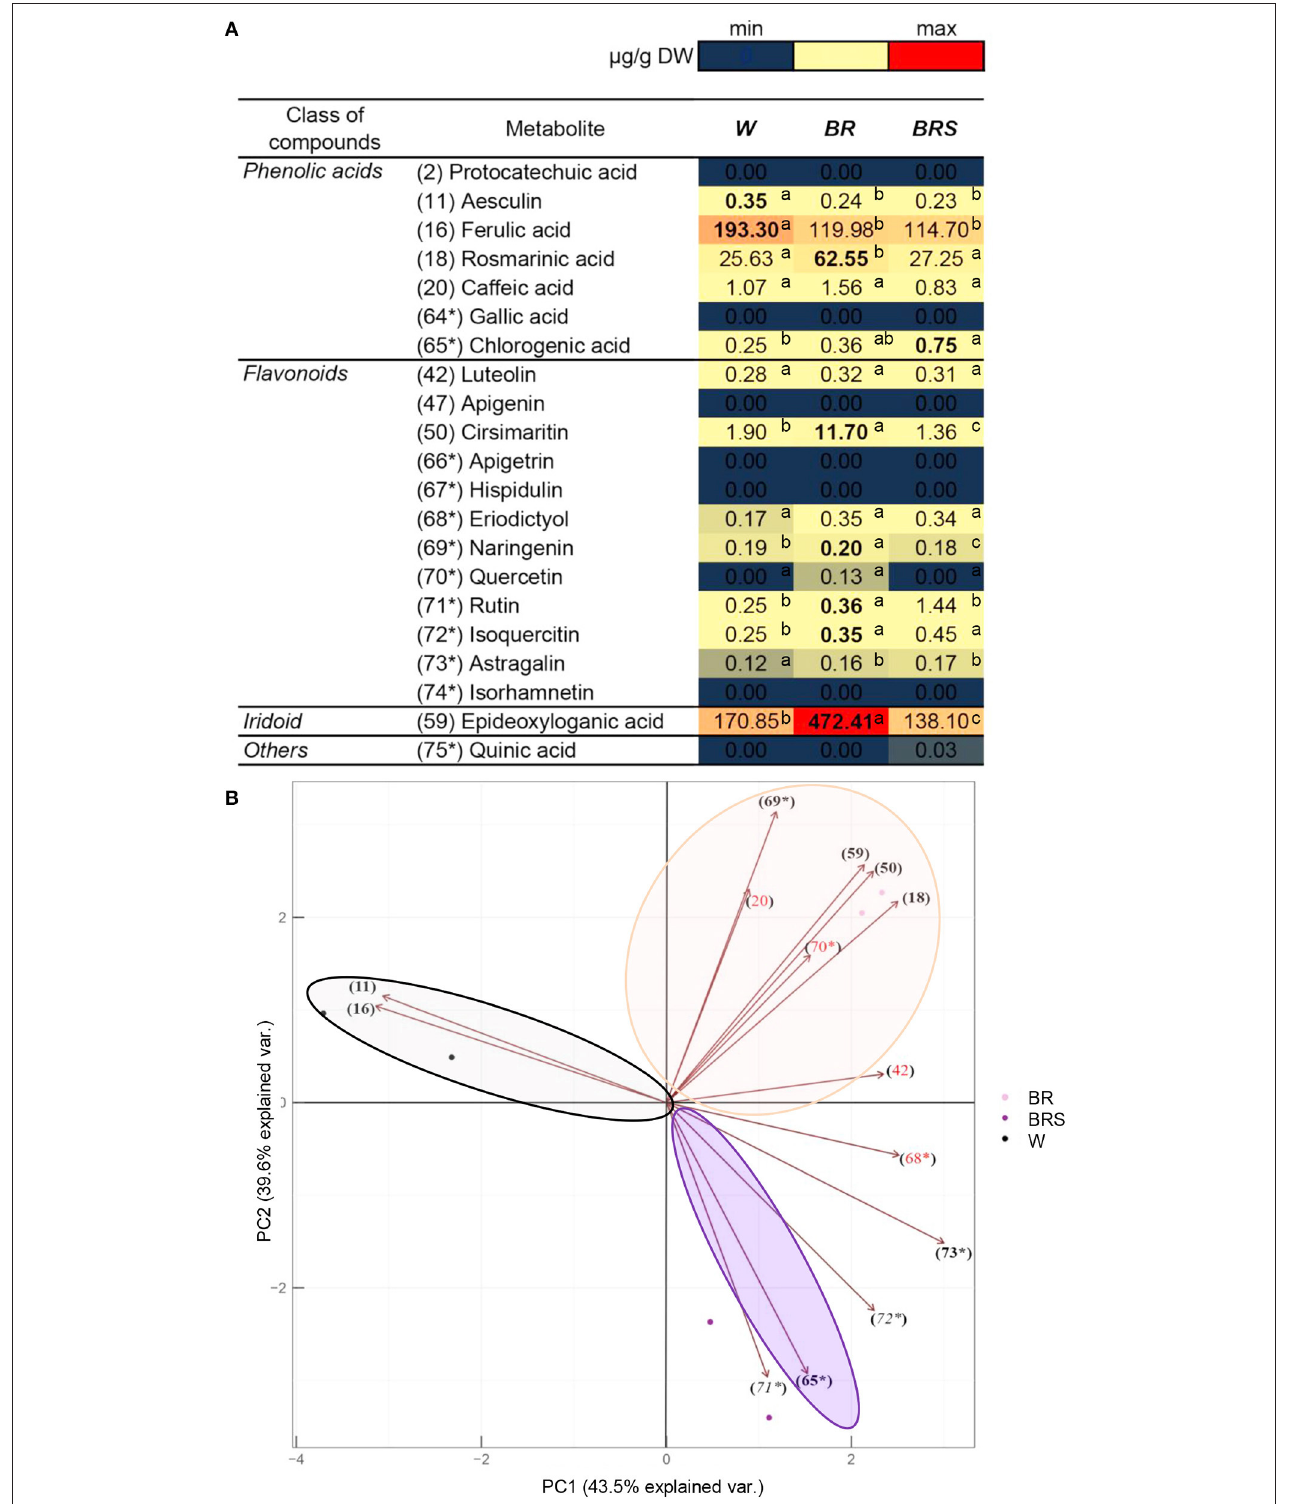
FIGURE 6 | Comparison of the quantity of major compounds between N. nuda light variants by using UHPLC/MS2 analysis. Based on identified compounds in this work and additional phenolic-related compounds (labeled 64* to 75*), in total 21 compounds were selected for comparative quantification. (A) Heat map visualization. One-way ANOVA (Holm–Sidak) test was applied to determine the statistical difference between the variants (shown in different letters). (B) PCA analysis. W, white light; BR, blue and red light; BRS, blue and red light with shadow.